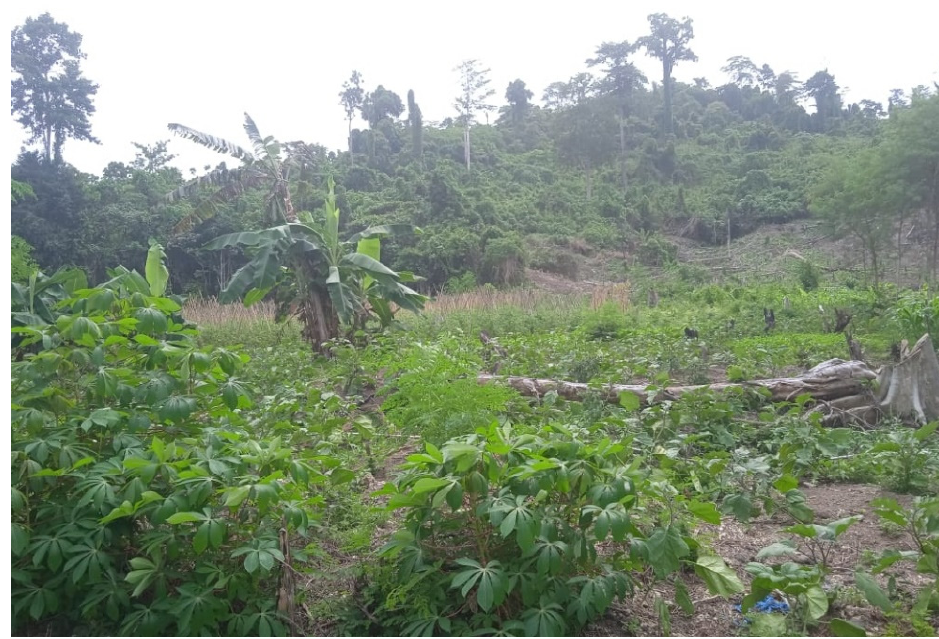
Figure 2. Typical field used for swidden cultivation in coastal areas of north Manokwari, West Papua, Indonesia, with a four-year-old fallow forest in the background (photo credit: Dony A. Djitmau).